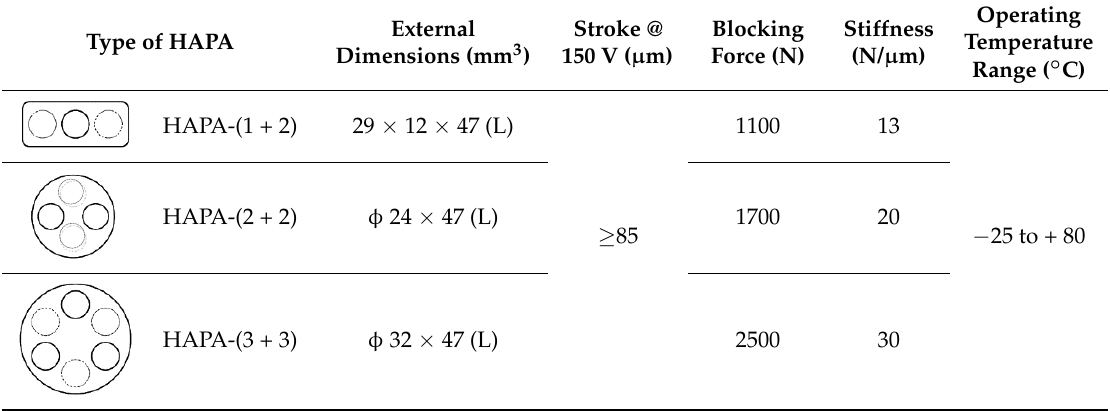
Table 1. Performance of various HAPAs made from NEC-Tokin piezoceramic stacks of 5 × 5 mm 2 in cross-section and 40 mm in length.